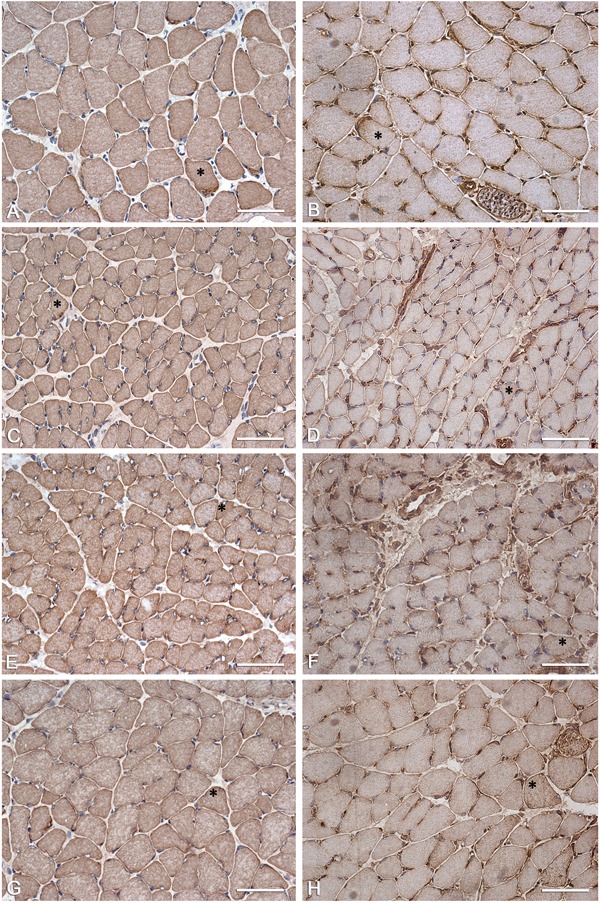
Photomicrographs of soleus muscle: immunostaining for desmin and vimentin. Cross-sections of soleus muscle were immunolabeled for intermediate filaments. A, C, E, G: desmin immunolabeling; B, D, F, H: vimentin immunolabeling. A (CG30), B (CG21), C (IG), D (IG), E (ISG), F (ISG), G (SG), and H (SG): desmin- and vimentin-positive cells are shown, and certain cells are more strongly stained than others (asterisks). Bars: 50 µm. CG21: 21-day control group; CG30: 30-day control group; IG: immobilized group; ISG: immobilized and stretched group; SG: stretched group.